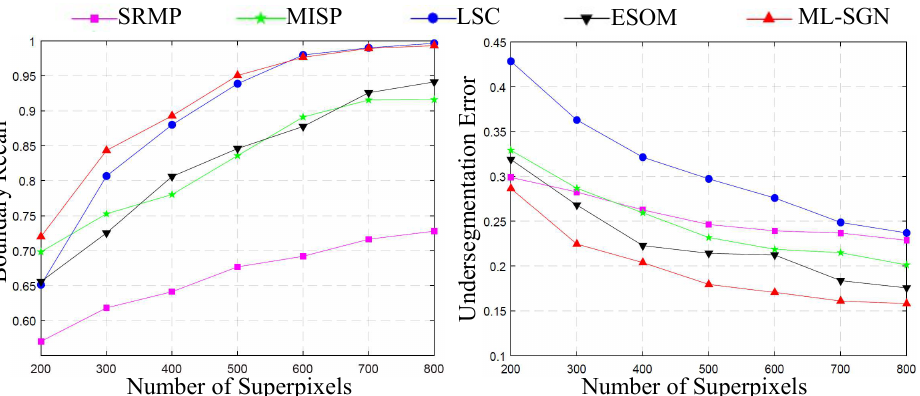
Figure 16. Comparison of the performances of different superpixel generation algorithms with different numbers of